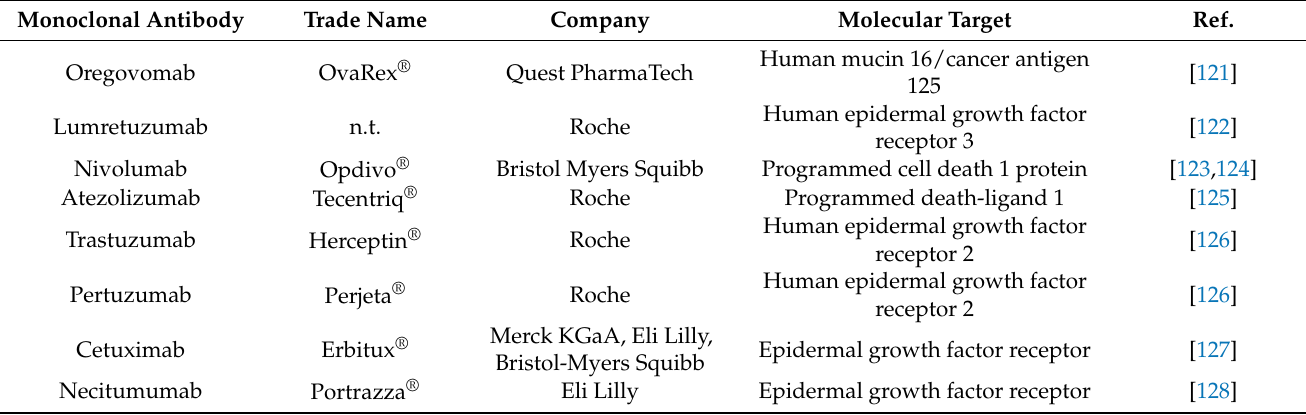
Table 2. Monoclonal antibodies tested in combination with paclitaxel and carboplatin and their molecular targets. Monoclonal